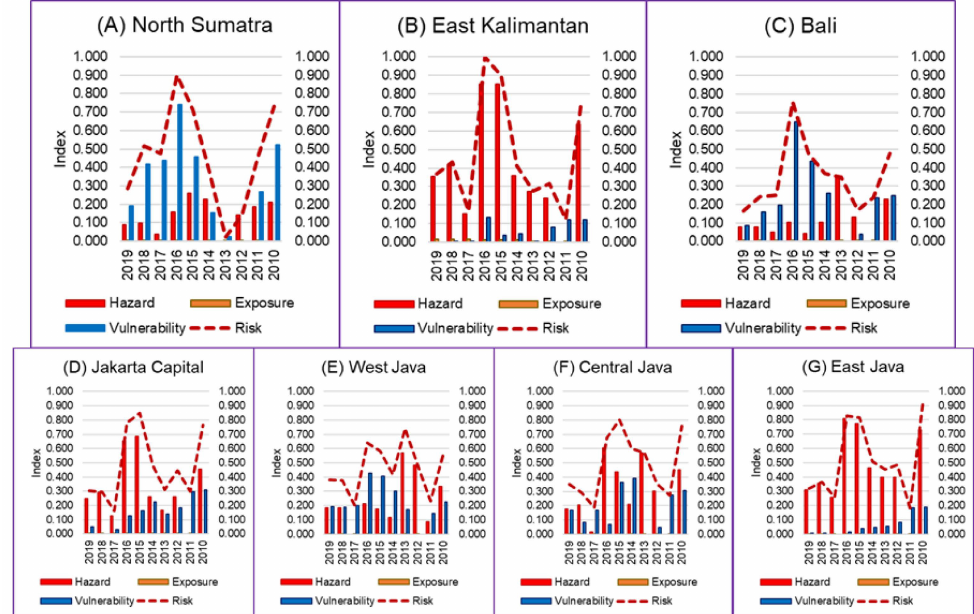
Figure 4. Dengue risk components of seven provinces in Indonesia: ( A ) North Sumatra Province, ( B ) East Kalimantan Province, ( C ) Bali Province, ( D ) Jakarta Capital Province, ( E ) West Java Province, ( F ) Central Java Province, ( G ) East Java